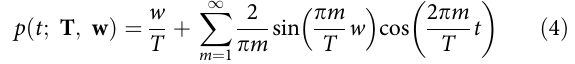
(Fig. 2a) and the convergence to a steady state (Supplementary Fig. 1a). In contrast, when T is relatively large ( T Z 4 min), the